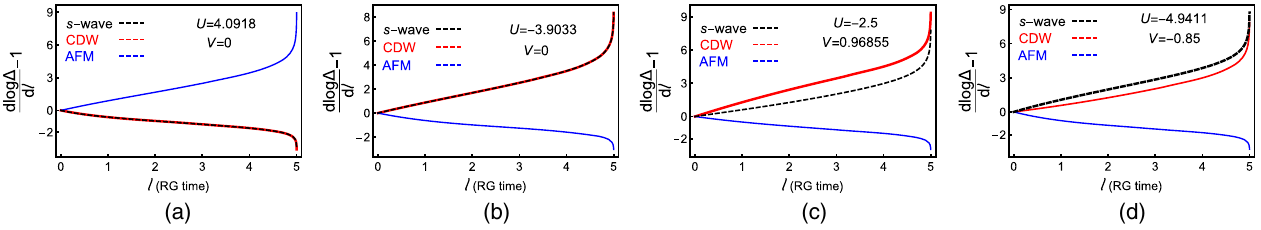
FIG. 13. Renormalization group flow of the source terms in the antiferromagnet (blue), charge density wave (red), and singlet s -wave pairing (black) channels for various choices for the bare strength (at l ¼ 0 ) of on-site ( U ) and nearest-neighbor ( V ) interactions in a uniaxially strained honeycomb lattice. The strengths of both interactions are quoted in dimensionless units. The onset of an order parameter is associated with the divergence ( → þ ∞ ) of the corresponding source term. The flow of the source terms shows that strong repulsive U > 0 causes formation of antiferromagnetic order [see panel (a)]. By contrast, for a strong attractive U < 0 , diverging susceptibilities in the CDW and s -wave pairing channels are exactly degenerate, as guaranteed by the pseudospin SU(2) symmetry of the system with V ¼ 0 (see Sec. VII A). These two orders nucleate simultaneously in the strong coupling regime [see panel (b)]. The addition of the nearest-neighbor interaction V breaks such exact degeneracy. In particular, V > 0 ( V < 0 ) favors the nucleation of the CDW ( s -wave pairing), as shown in panel (c) [panel (d)]. The resulting phase diagram in the U - V plane is shown in Fig. 4(b). For the clarity of presentation, we here do not present the RG flow of the remaining channels. We have verified that, in the entire phase diagram, only one of these three channels displays the leading divergence at strong